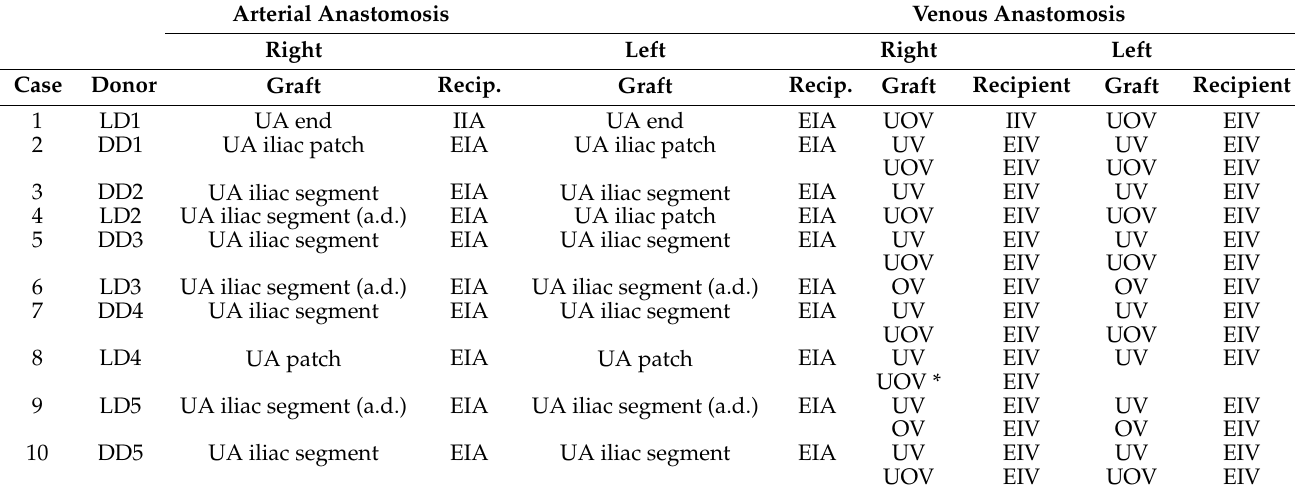
Table 2. Vascular anastomosis details in 10 consecutive uterus transplant recipients. Arterial Anastomosis Venous Anastomosis Right Left Right Left Recip. Recip. Graft